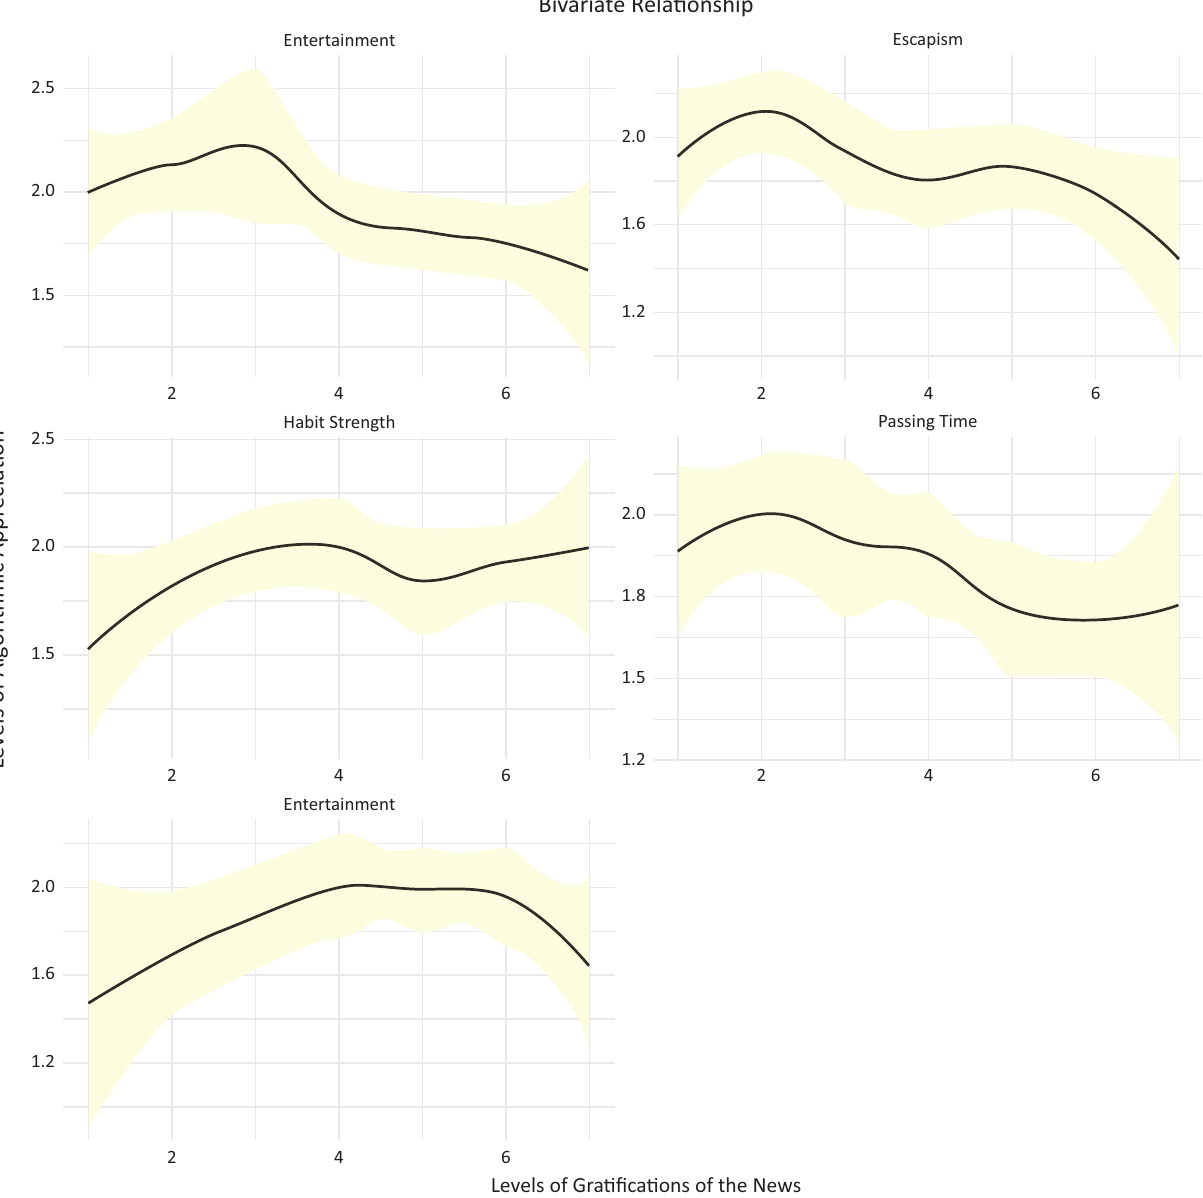
Figure 3. Bi‐variate relations between algorithmic appreciation and gratifications of the